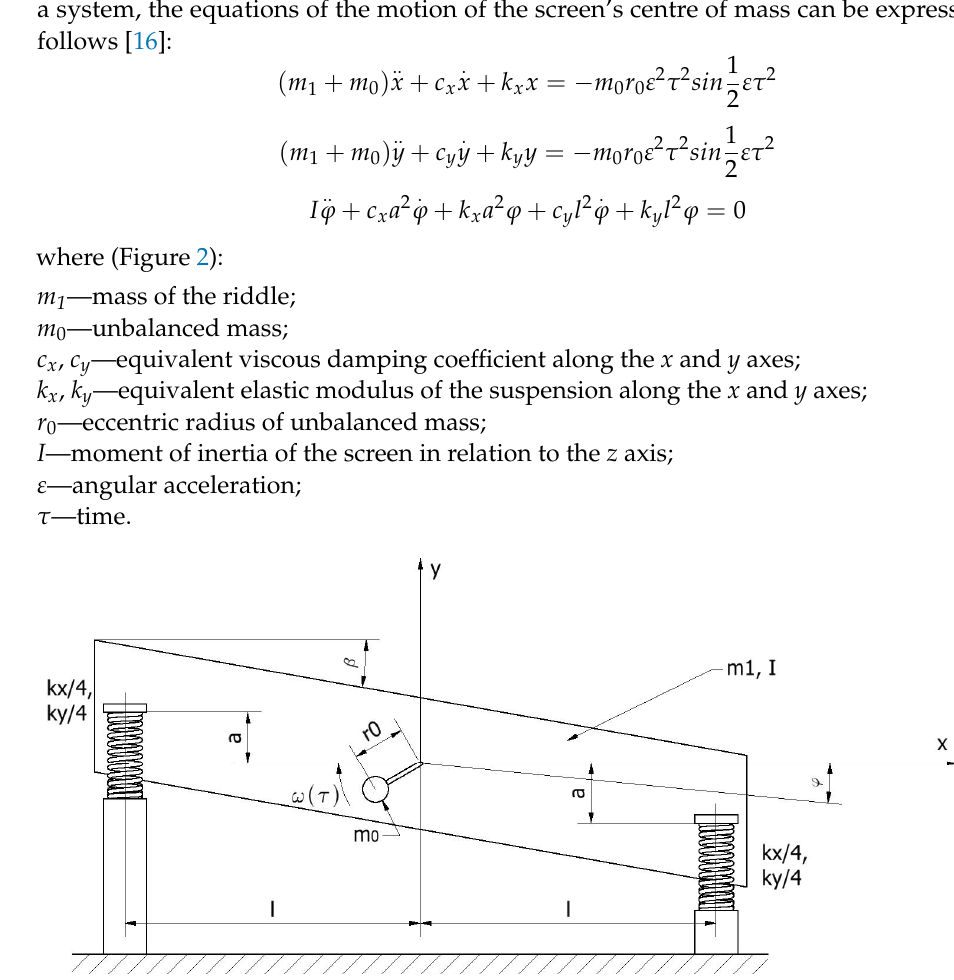
(0–960 rpm), II—steady operation (960 rpm), III—braking (960–0 rpm). The duration